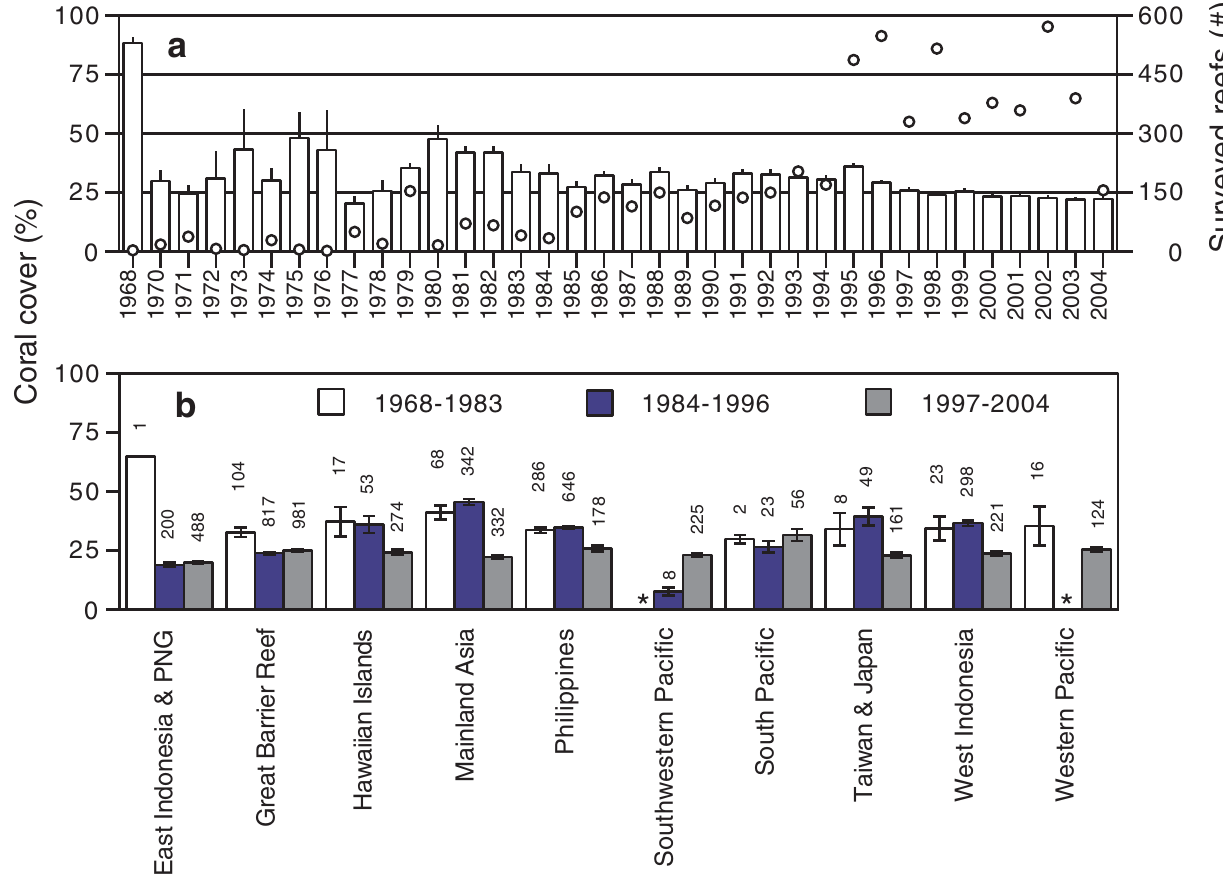
Figure 3. Regional trends in coral cover between 1968 and 2004. (a) White bars represent Indo-Pacific coral cover and open symbols (right axis) are the number of reefs surveyed each year. (b) Coral cover in ten Indo-Pacific subregions in each of three periods. Plotted values are means 6 1 SE and values above each bar are the subregional sample sizes. *=no data were available